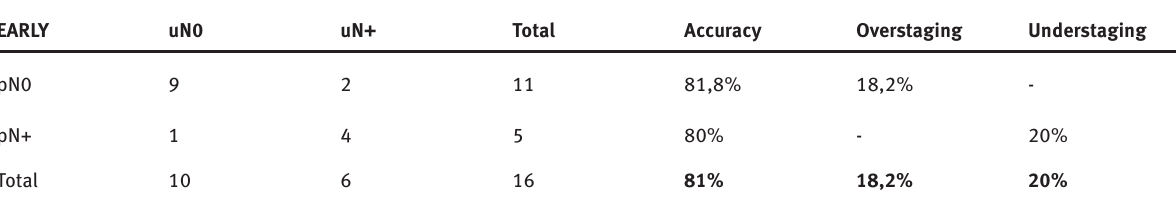
Table 3 : Accuracy, overstaging and substaging risk for uN stages – Early group